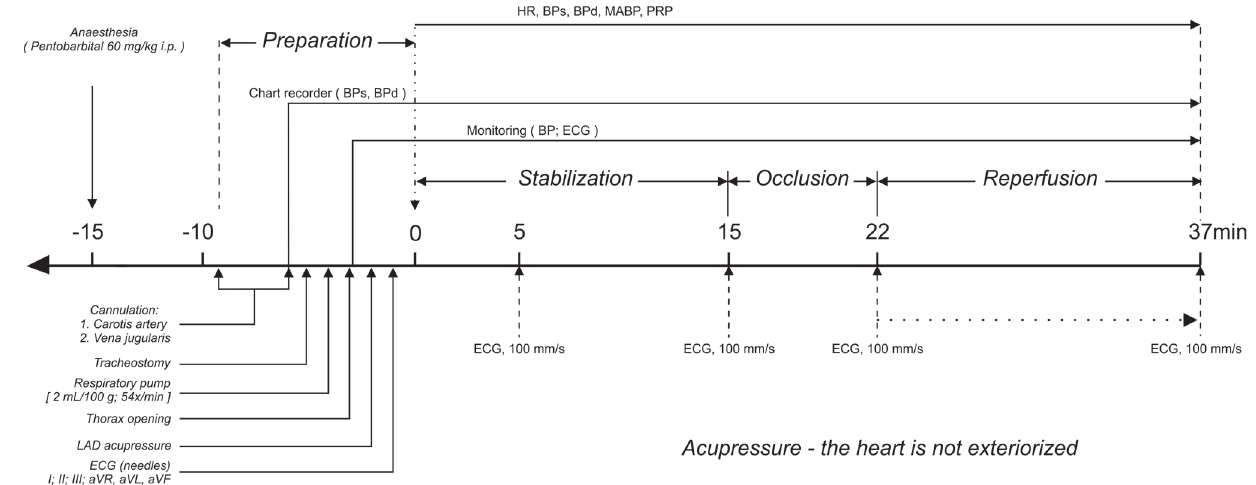
Figure 2. Schedule of the protocol study.